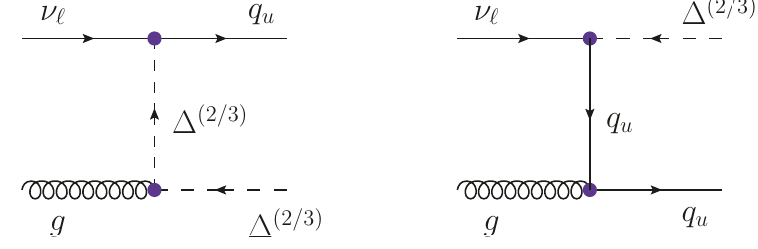
Figure 8 . Feynman diagrams contributing to the process g + (cid:23) ‘ decays into (cid:22) q u + (cid:23) ‘ 0